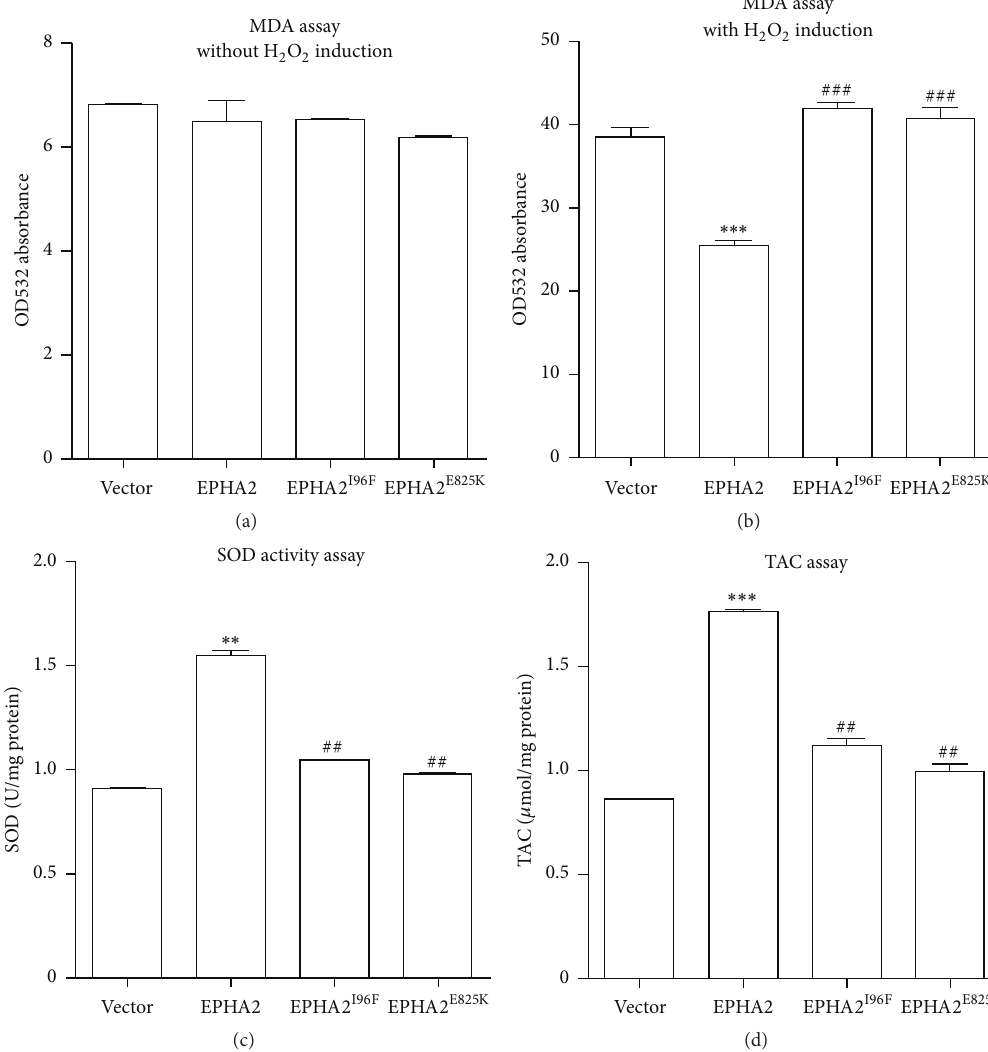
Figure 5: The nonsynonymous polymorphisms nullify the antioxidative capacity of EPHA2. (a-b) The lipid oxidation was evaluated with MDA assays in the HLECs before and after H 2 O 2 treatment. The overexpression of EPHA2 reduces the absorbance value of cell lysate with H 2 O 2 treatment, while the introduction of EPHA 2 I 96 F or EPHA 2 E 825 K mutant does not decline the lipid oxidation. (c-d) The SOD activity and the total antioxidative capacity were tested with SOD and TAC assay kit, respectively. The data are presented as U/mg or 𝜇 mol/mg proteins. The upregulation of SOD level and total antioxidant content by EPHA2 is abrogated by the cataract-associated SNPs. ∗ 𝑝 < 0.05 , ∗∗ 𝑝 < 0.01 , and ∗∗∗ 𝑝 < 0.001 versus vector control; ## 𝑝 < 0.01 , ### 𝑝 < 0.001 compared with wild-type